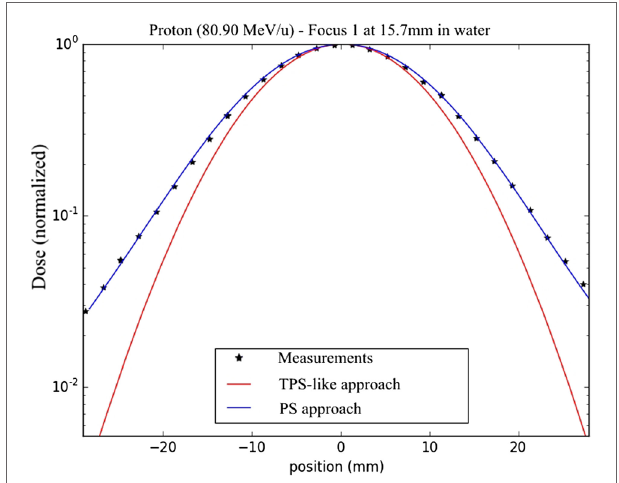
FigUre 10 | Dose results and measurements at 15.7 mm in water, for lateral dose profiles from line scans for the lowest energy protons and focus 1 with a semi-logarithmic scale; the TPs-like approach is displayed in red, the Ps approach in blue and the measurements with the star